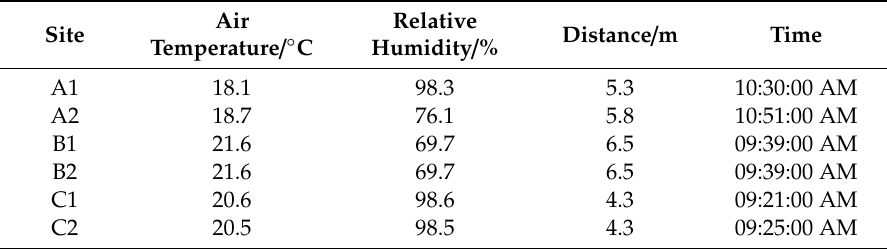
Table 1. Parameters of the data acquisition at di ff erent